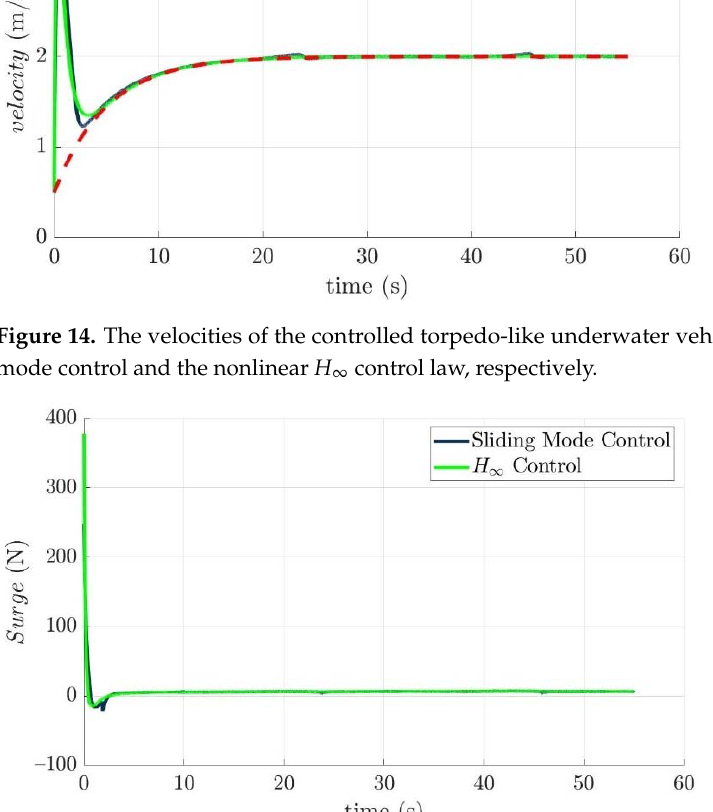
Figure 15. Surge forces of the developed torpedo-like underwater vehicle with respect to the sliding mode control law and the nonlinear H ∞ control law.